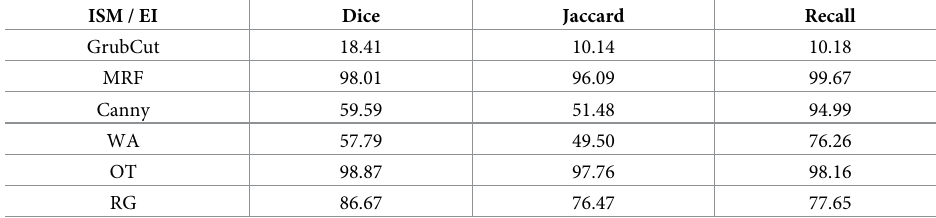
Table 8. A comparison of single-object segmentation methods using EMDS-5. Image segmentation methods (ISM), Evaluation index (EI), Watershed algorithm (WA), Otsu thresholding (OT), Region growing (RG). (In [%].).